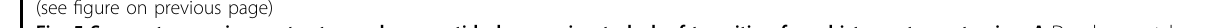
Fig. 5 Spermatogenesis arrests at round spermatid phase owing to lack of transition from histones to protamine. A Developmental trajectory from spermatogonia B to round spermatids. B Representative gene ontology (GO) terms of upregulated and downregulated genes among clusters during spermatogenesis. Downregulated GO terms are in blue, upregulated GO terms are in pink. The number of upregulated and downregulated genes is indicated. C Dotplot showing the expression of representative genes in each cluster. D Immuno fl uorescence analysis of ovotestis using Sycp3 antibody (second antibody, TRITC-conjugated immunopure goat anti-rabbit IgG(H + L)). The nuclei were stained with DAPI. Sc spermatocytes. Scale bar: 20 µm. E Immuno fl uorescence analysis of ovotestis using Spag6 antibody (second antibody, TRITC-conjugated immunopure goat anti-rabbit IgG(H + L)). The nuclei were stained with DAPI. Sc spermatocytes, St round spermatids. Scale bar: 20 µm. F UMAP maps showing expression patterns of marker genes during spermatogenesis. Protamine was scarcely expressed, while histones were obviously expressed in round spermatids. G RT-PCR analysis of protamine expression pattern in ovotestis and testis. RT-PCR was performed using cDNAs as template. β - actin was used as an internal control. H Immuno fl uorescence analysis of ovotestis using H2b antibody (second antibody, FITC-conjugated immunopure goat anti-rabbit IgG(H + L)). The nuclei were stained with DAPI. St, round spermatids. Scale bar: 20 µm. I Immuno fl uorescence analysis of testis using H2b antibody (second antibody, TRITC-conjugated immunopure goat anti-rabbit IgG(H + L)). The nuclei were stained with DAPI. Round spermatids (St) and elongate spermatids (Est) are indicated by arrows. Scale bar: 20 µm. J Statistical analysis of cell number showing differentiation arrest from early round spermatids (cluster 9) to late round spermatids (cluster 10). K Schematic model of differentiation arrest from early round spermatids to late round spermatids owing to lack of transition from histone to